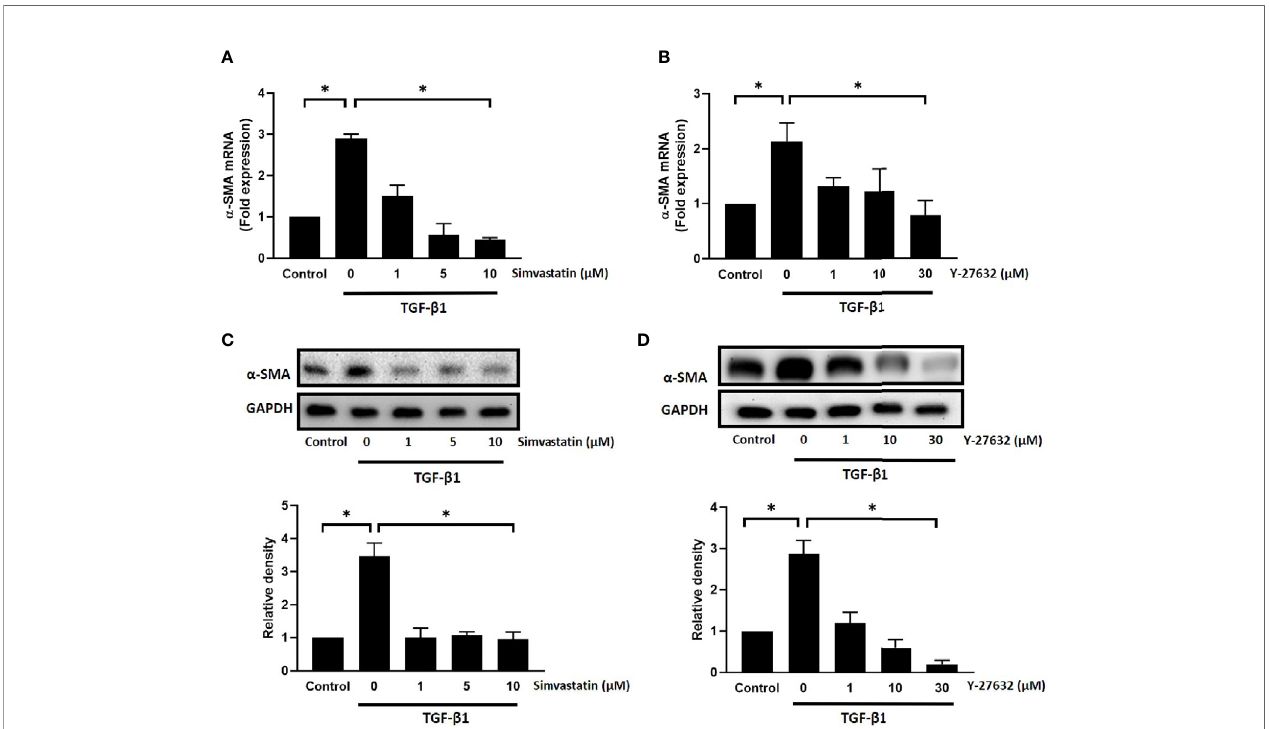
FIGURE 2 | Effect of simvastatin and ROCK inhibitor Y-27632 on transforming growth factor- b (TGF- b )-induced a -smooth muscle actin ( a -SMA) messenger RNA (mRNA) and protein expression in Graves ’ ophthalmopathy (GO) orbital fi broblasts. Primary cultured GO orbital fi broblasts were stimulated with TGF- b 1 (3 ng/mL) for 48 h with or without a 1-h pretreatment with different concentrations of simvastatin (1, 5, 10 m M) (A, C) or ROCK inhibitor Y-27632 (1, 10, 30 m M) (B, D) . The a - SMA mRNA expression was examined using real-time PCR (A, B) . The a -SMA protein production was determined using western blot analysis (C, D) . Data are presented as mean ± SD from at least three independent experiments. *p <